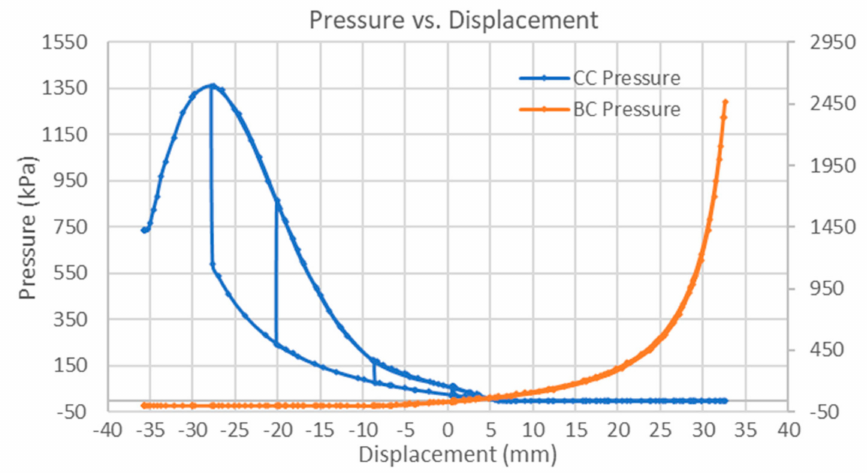
Figure 8. Operation with load: pressure vs. displacement profile for CF =